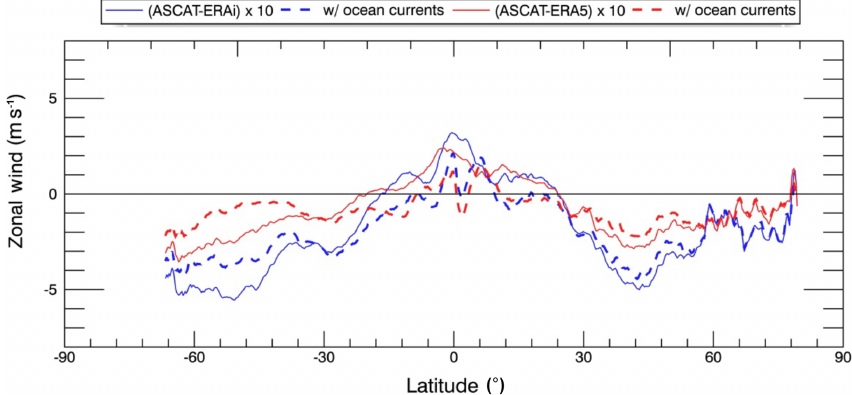
Figure 10. Zonally averaged mean zonal wind differences between ASCAT and differences with ERA-Interim (blue line) and ERA5 (red line) first-guess winds over 2016, before (continuous lines) and after (dashed lines) the ocean current correction. Note that differences have been scaled by 10.